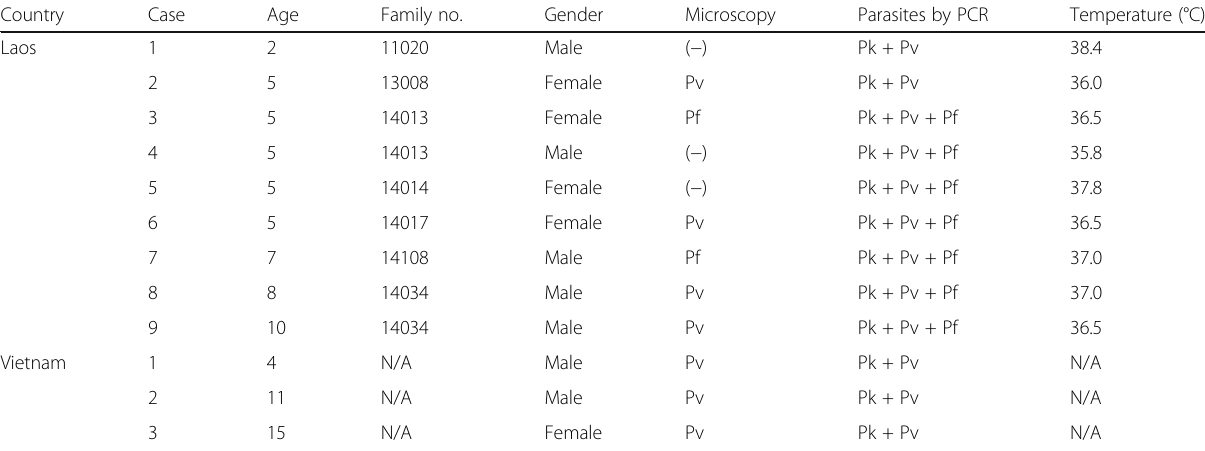
Table 3 Characteristics of people infected with Plasmodium knowlesi Country Case Family